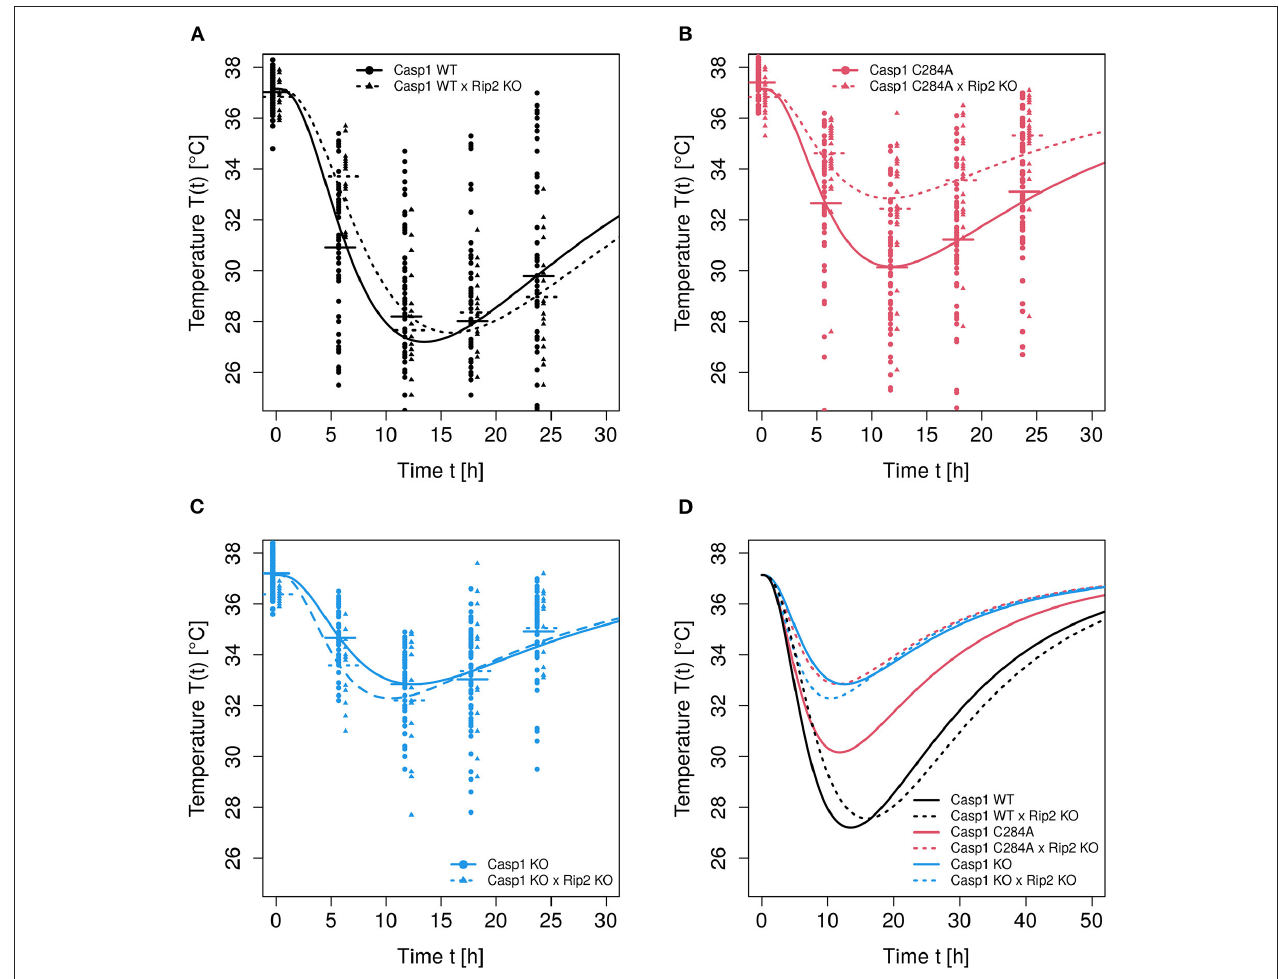
FIGURE 2 | Observed and predicted temperature-time courses. Modeling of temperature-time curves was performed using model Equation (5) with s = 3, estimating k and p 0 as group specific. (A–C) Temperature-time courses (observations plus model predictions) of the respective genotypes Casp 1 WT , Casp 1 C 284 A and Casp 1 KO (each on Rip 2 WT or Rip 2 KO background). (D) All 6 predicted temperature-time courses are